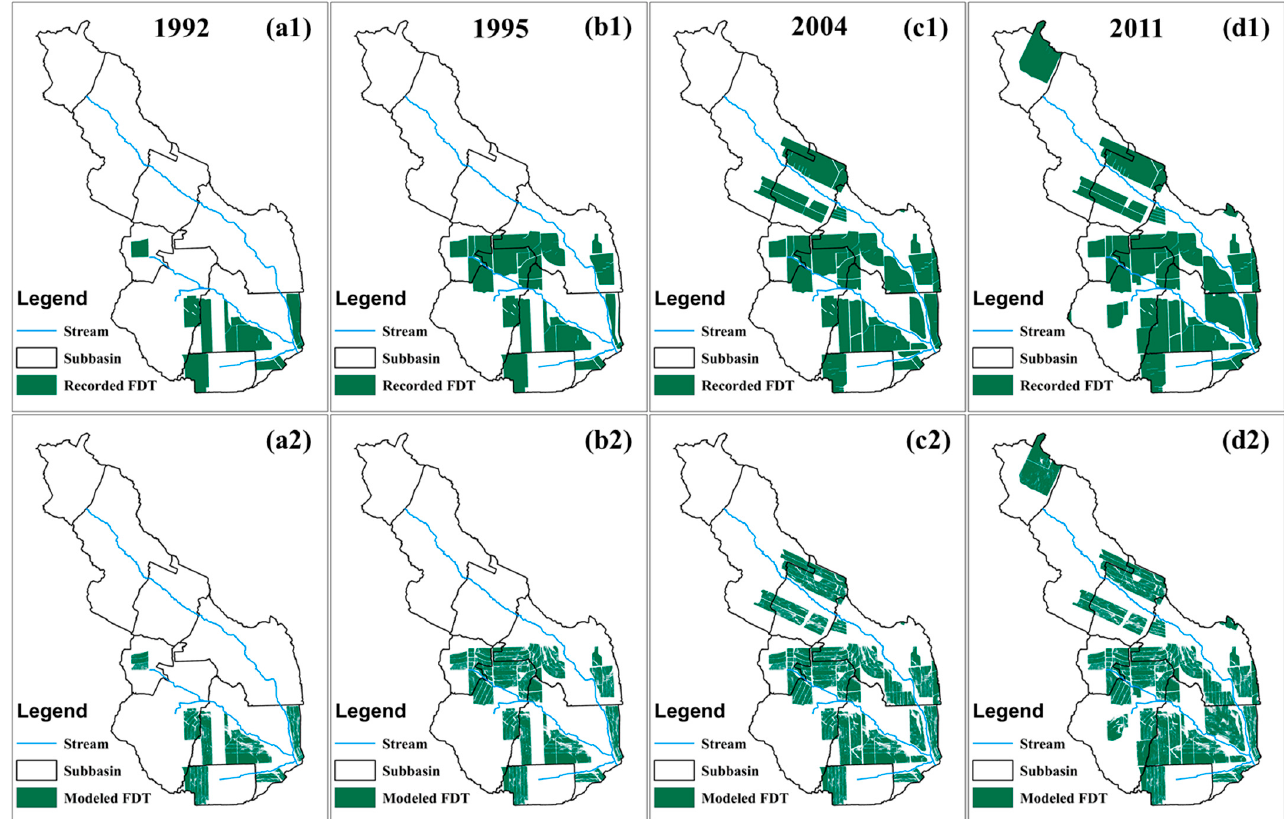
Figure 8. Recorded (top panels) and input (bottom panels) FDT protected areas in the BBW for ( a1 versus a2 ) 1992, ( b1 versus b2 ) 1995, ( c1 versus c2 ) 2004, and ( d1 versus d2 ) 2011. Results are from the SWAT1 model.